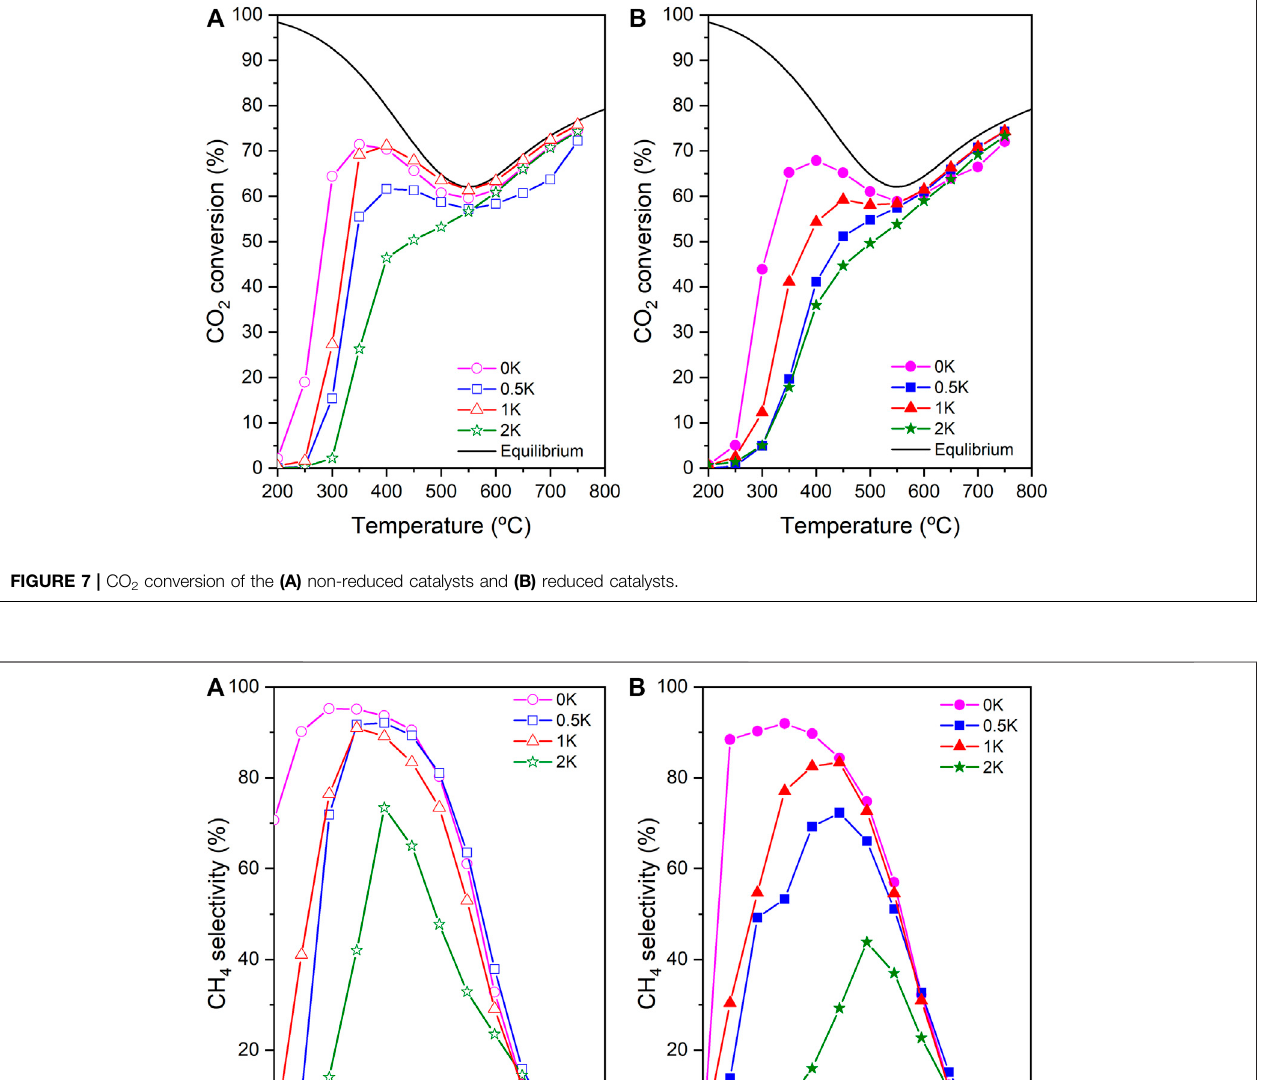
Frontiers in Chemistry |